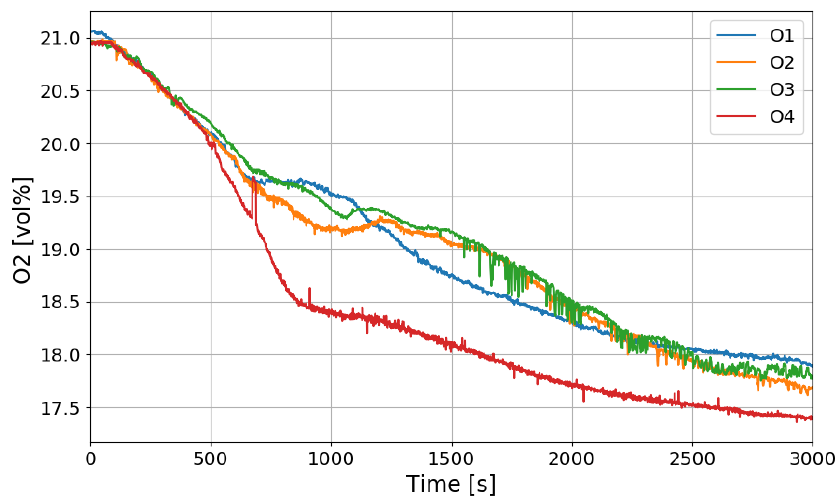
Figure 12. Oxygen concentration distributions over time for the SP1 test.